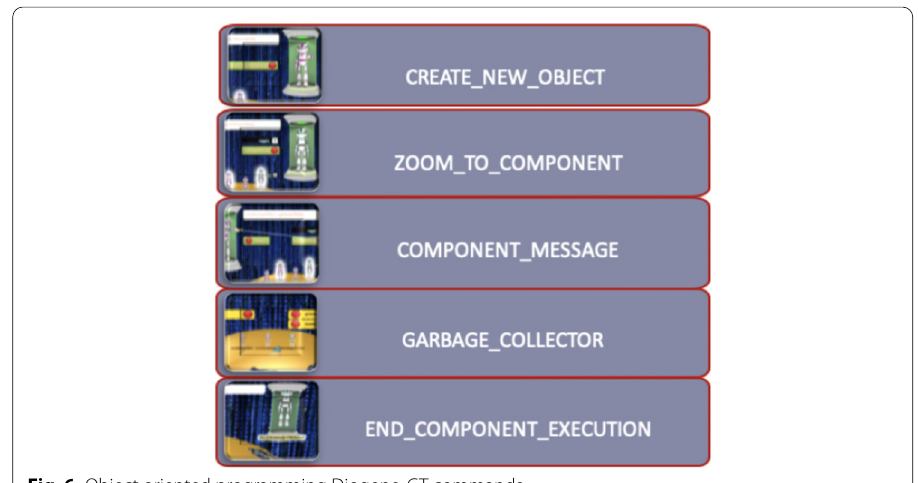
Fig. 6 Object oriented programming Diogene-CT